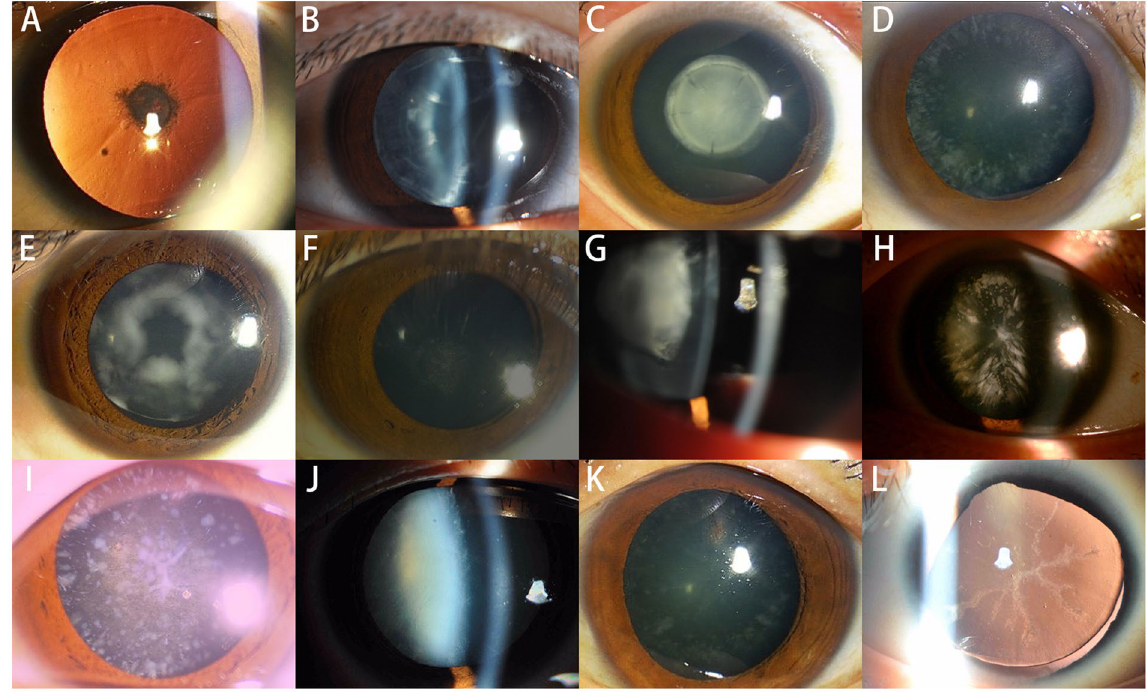
Figure 3. Phenotypes of the probands. ( A ) Photograph of proband in family 1 presented an anterior polar cataract. ( B ) Slit-lamp photograph of proband in family 4 showed a progressive cortical and sutural cataract. ( C ) Photograph of proband in family 5 showed a perinuclear zonular cataract. ( D ) Photograph of proband of family 6 showed a lamellar cataract with fine punctate opacities involving the cortical area of lens. ( E ) Photograph of proband in family 7 showed a subluxation of lens with a lamellar cataract. ( F ) Photograph of proband in family 14 presented a posterior polar cataract. ( G ) Slit-lamp photograph of proband in family 15 presented a nuclear cataract. ( H ) Photograph of proband in family 16 presented a cerulean cataract. ( I ) Photograph of proband in family 17 presented a cerulean cataract. ( J ) Slit-lamp photograph of proband in family 18 presented a total cataract. ( K ) Photograph of proband in family 19 showed a lamellar punctate cataract. ( L ) Photograph of proband in family 24 showed a coralliform cataract with aniridia.